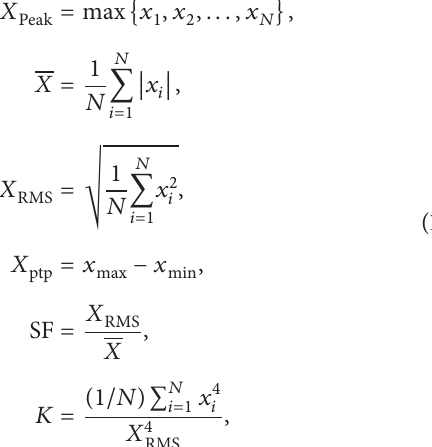
Figure 1: Flow diagram of obtaining the symptom parameter